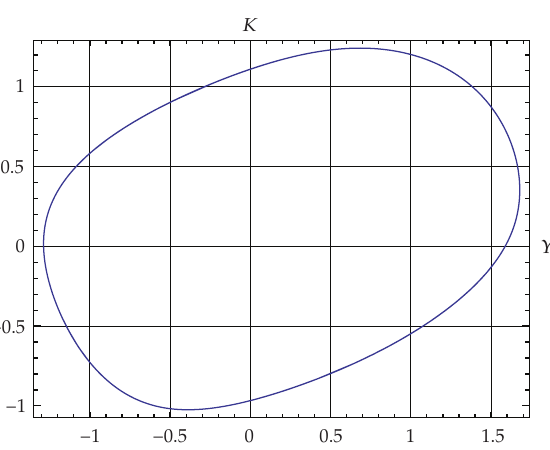
Figure 1: A stable limit cycle is generated when (cid:5) μ 1 ,μ 2 (cid:6) is in the region between H and P